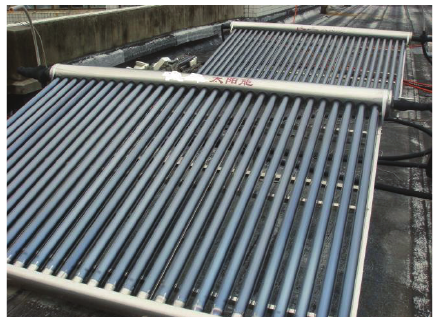
Figure 4: The picture of solar water heater.